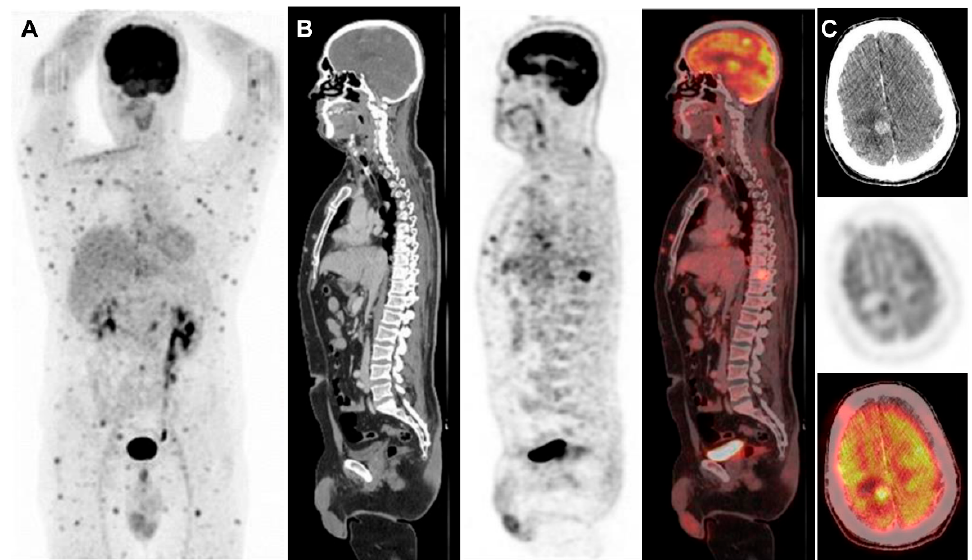
Figure 1. 50-Year-old man diagnosed with nodular melanoma, underwent surgical removal of the lesion in the right dorsal region and biopsy of the sentinel lymph node in the right axilla, that showed no metastatic involvement at histopathological examination. After ten months, a new lesion appeared in the right clavicular region. The patient, therefore, underwent local surgery with lymphadenectomy of right cervical lymph nodes that were metastatic at histology with no mutations of BRAF proto-oncogene by polymerase chain reaction. Thus, the patient could not benefit from therapy with BRAF inhibitors targeting the protein kinase BRAF. This kinase, when mutated, drives neoplastic transformation through the constitutive activation of the downstream signaling pathway regulating cell division and di ff erentiation [1]. Whole-body 18F-FDG-PET / CT and contrast-enhanced CT of the brain, performed after surgery, showed no evidence of disease. In the following six months, multiple subcutaneous nodules were observed throughout the body and therefore, a 18F-FDG-PET / CT scan was performed. ( A ) Maximum intensity projection view; ( B ) Sagittal whole-body CT, PET and fusion images; ( C ) Transaxial CT, PET and fusion images of the brain. The scan showed multiple sites of metastatic involvement in various districts throughout the body. In particular, focal 18F-FDG uptake was found in a brain lesion of the right parietal lobe; in a lytic lesion of the frontal bone (SUVmax 7.1); in multiple cervical, thoracic and abdomino-pelvic lymph nodes (SUVmax 6.3); in a lytic lesion of the tenth thoracic vertebra (SUVmax 8) and in multiple nodular lesions in the subcutaneous and muscular tissues throughout the body (SUVmax 8.2).